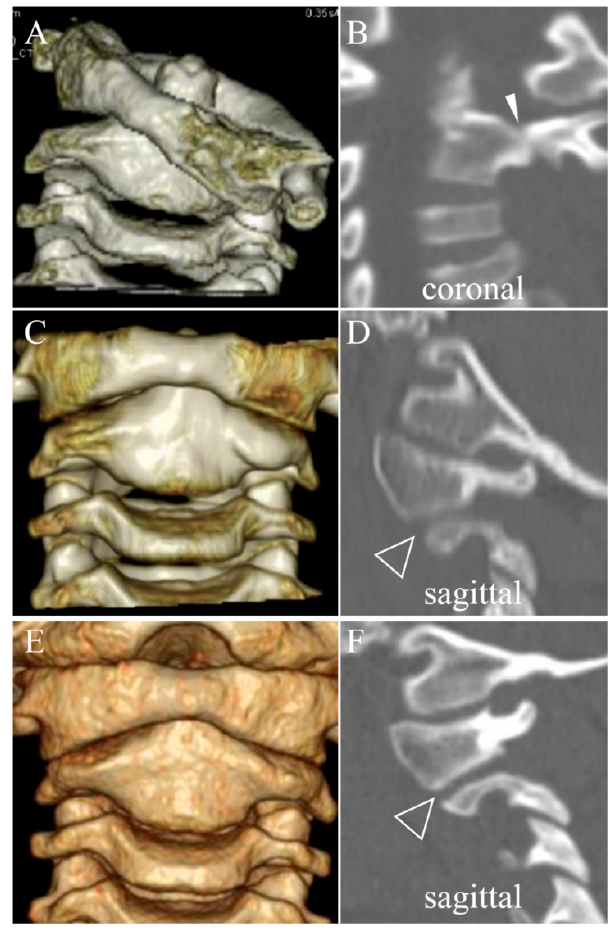
Figure 1. Representative non-fusion case (case 7) of 6-year-pld boy with Fielding type 3 and Ishii grade 3 ( A ). Direct osseous contact of C1/C2 facet on the dislocated side at initial visit (solid arrowhead in ( B )), disappeared after reduction and during halo fixation ( C ), blank arrowhead in ( D ), and resulted in remodeling of facet deformity without osseous fusion at the final follow-up ( E ), open arrowhead in ( F ). Duration of halo fixation was 2.6 months.